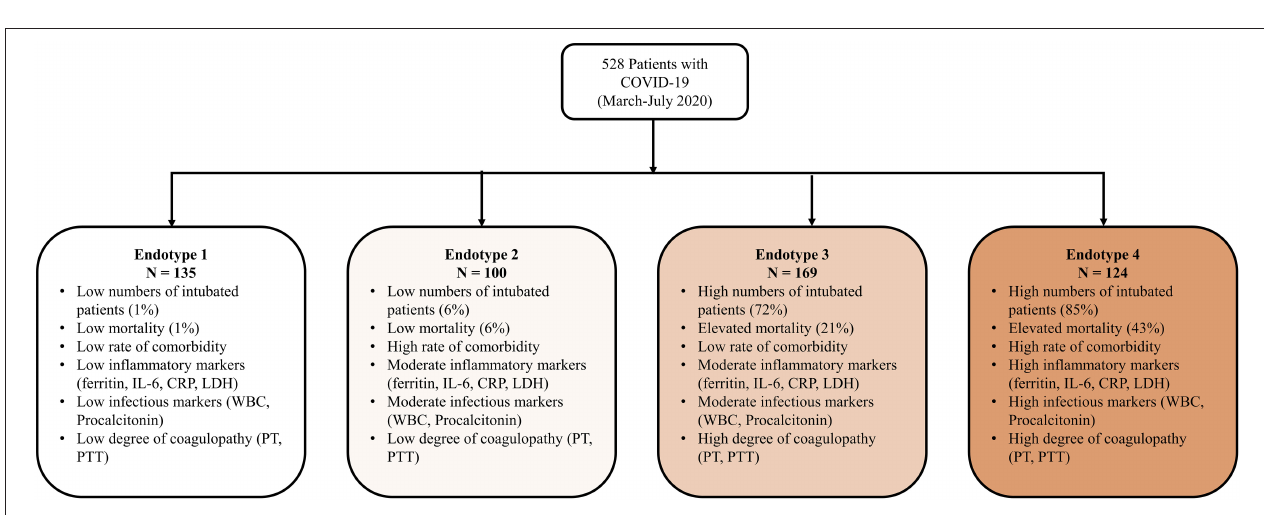
FIGURE 3 | Summary of the four endotypes. A summary of the four identified endotypes is